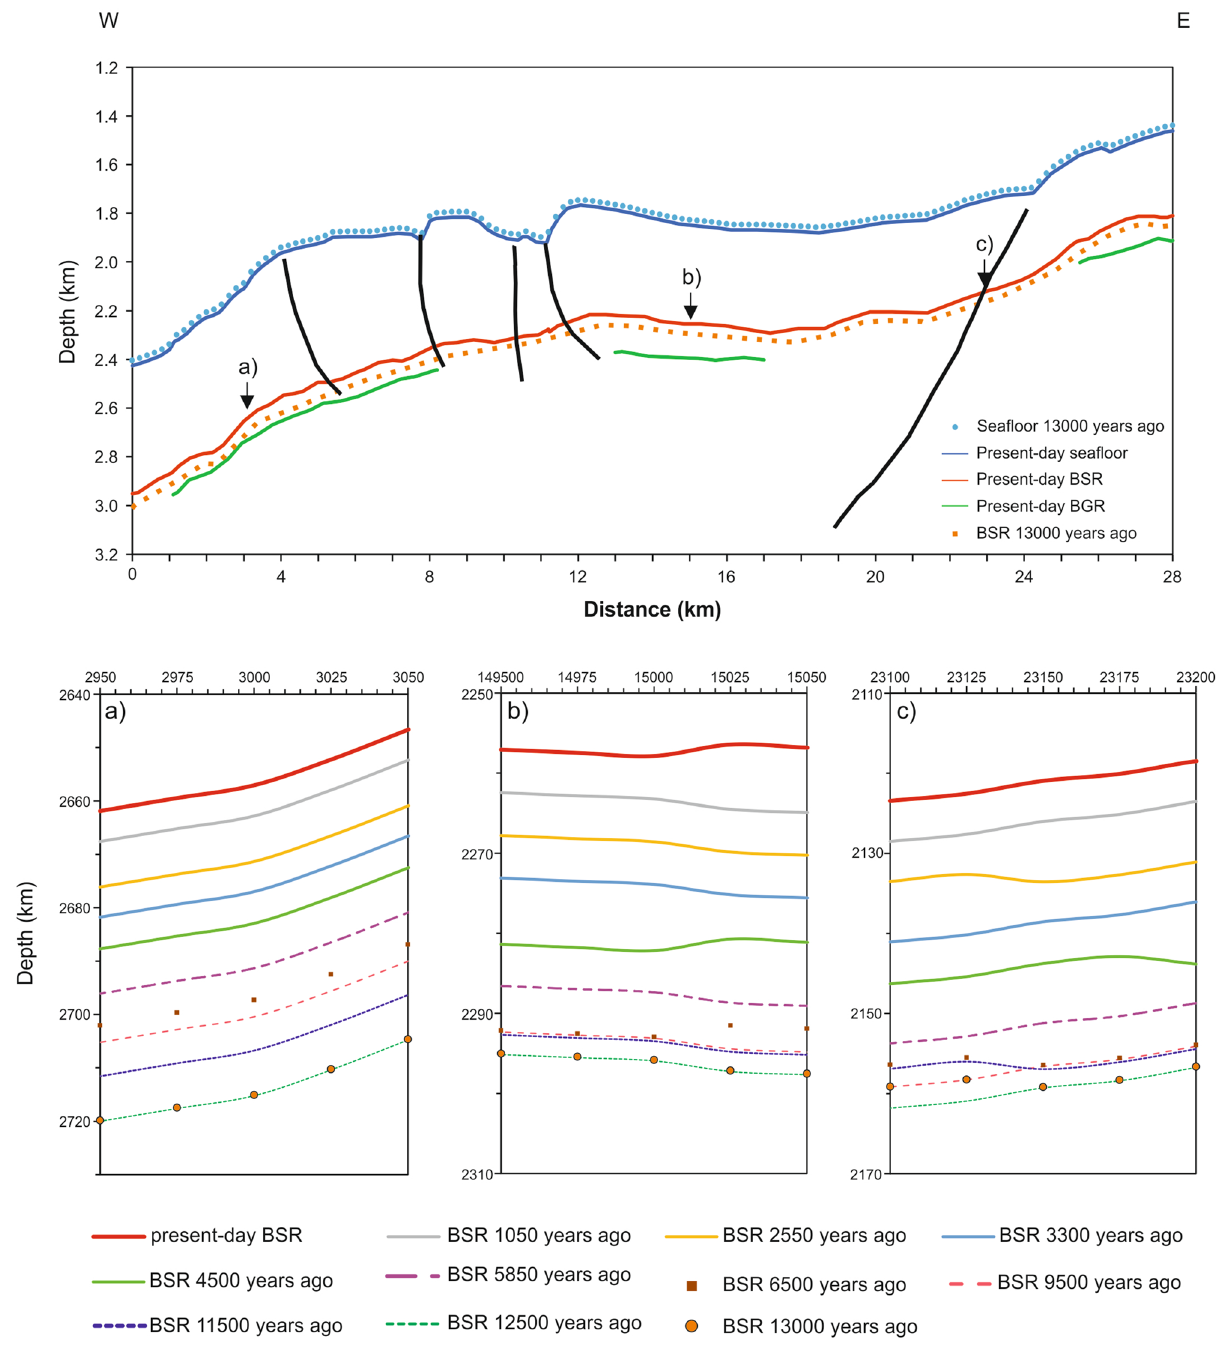
Figure 7. Modeling of MGL1701-30 section over 13,000 years BP. The top panel shows seafloor (blue), BSR (red) and BGR (green) at the present and seafloor (blue dots) and BSR (orange dots) at 13,000 years BP. The black lines represent the faults, reported in Fig. 2. The bottom panels show the BSR depth variation versus time around three selected positions, as indicated by the arrows in the top